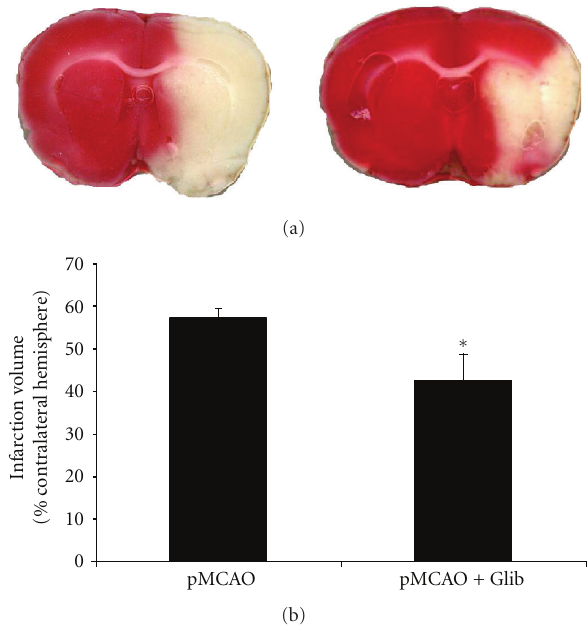
Figure 1: Glib reduces infarct volume. (a) TTC-stained coronal sections from representative animals given either vehicle or Glib, in brains harvested 48 h after occlusion. Infarcts are shown as pale (unstained) regions involving the striatum and overlying cortex. The infarct area in Glib-treated animals is substantially reduced. alone, Glib significantly reduced hemispheric infarct volumes